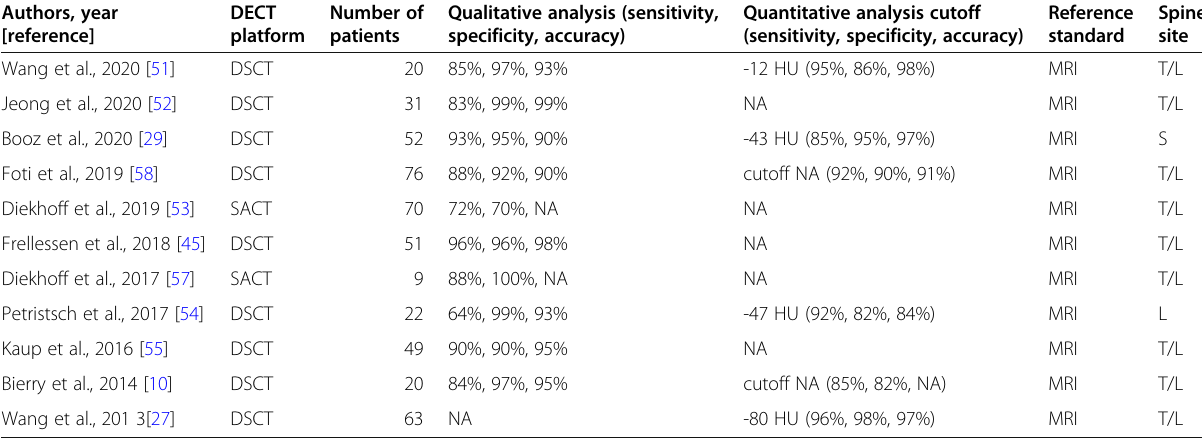
Table 2 Virtual non-calcium computed tomography (CT) ability to depict traumatic bone marrow edema on dual-energy spine